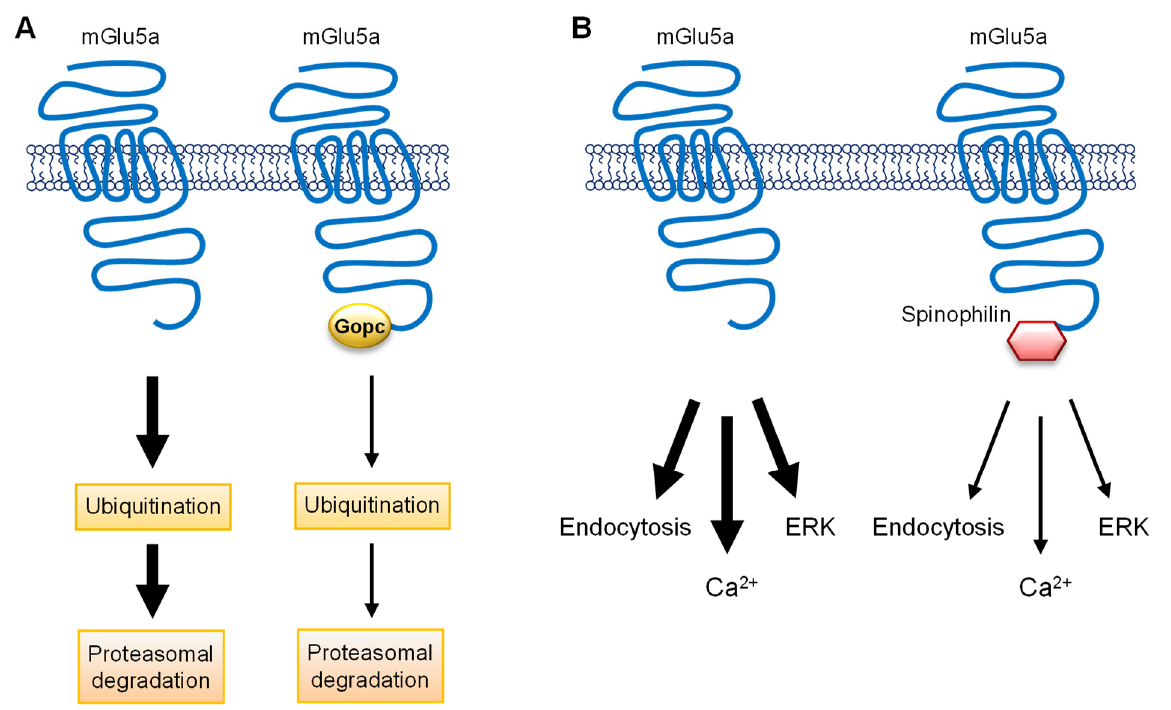
Figure 2. Schematic diagrams illustrating the roles of Gopc and spinophilin in the regulation of mGlu5a receptors. ( A ) The role of Gopc in the regulation of mGlu5a receptors. The mGlu5a receptor is subject to ubiquitination, followed by proteasomal degradation. Gopc via its PDZ domain binds to the PDZ motif on the distal end of mGlu5a CT. This Gopc–mGlu5a interaction inhibits the ubiquitination process of mGlu5a and thereby upregulates the expression level of mGlu5a receptors. ( B ) The role of spinophilin in the regulation of mGlu5a receptors. Spinophilin interacts with the PDZ motif on mGlu5a CT and inhibits the ligand-induced endocytosis of the receptors in cortical neurons. Moreover, spinophilin limits the mGlu5a ‐ mediated signaling events (Ca 2+ and ERK) in response to agonist stimulation.